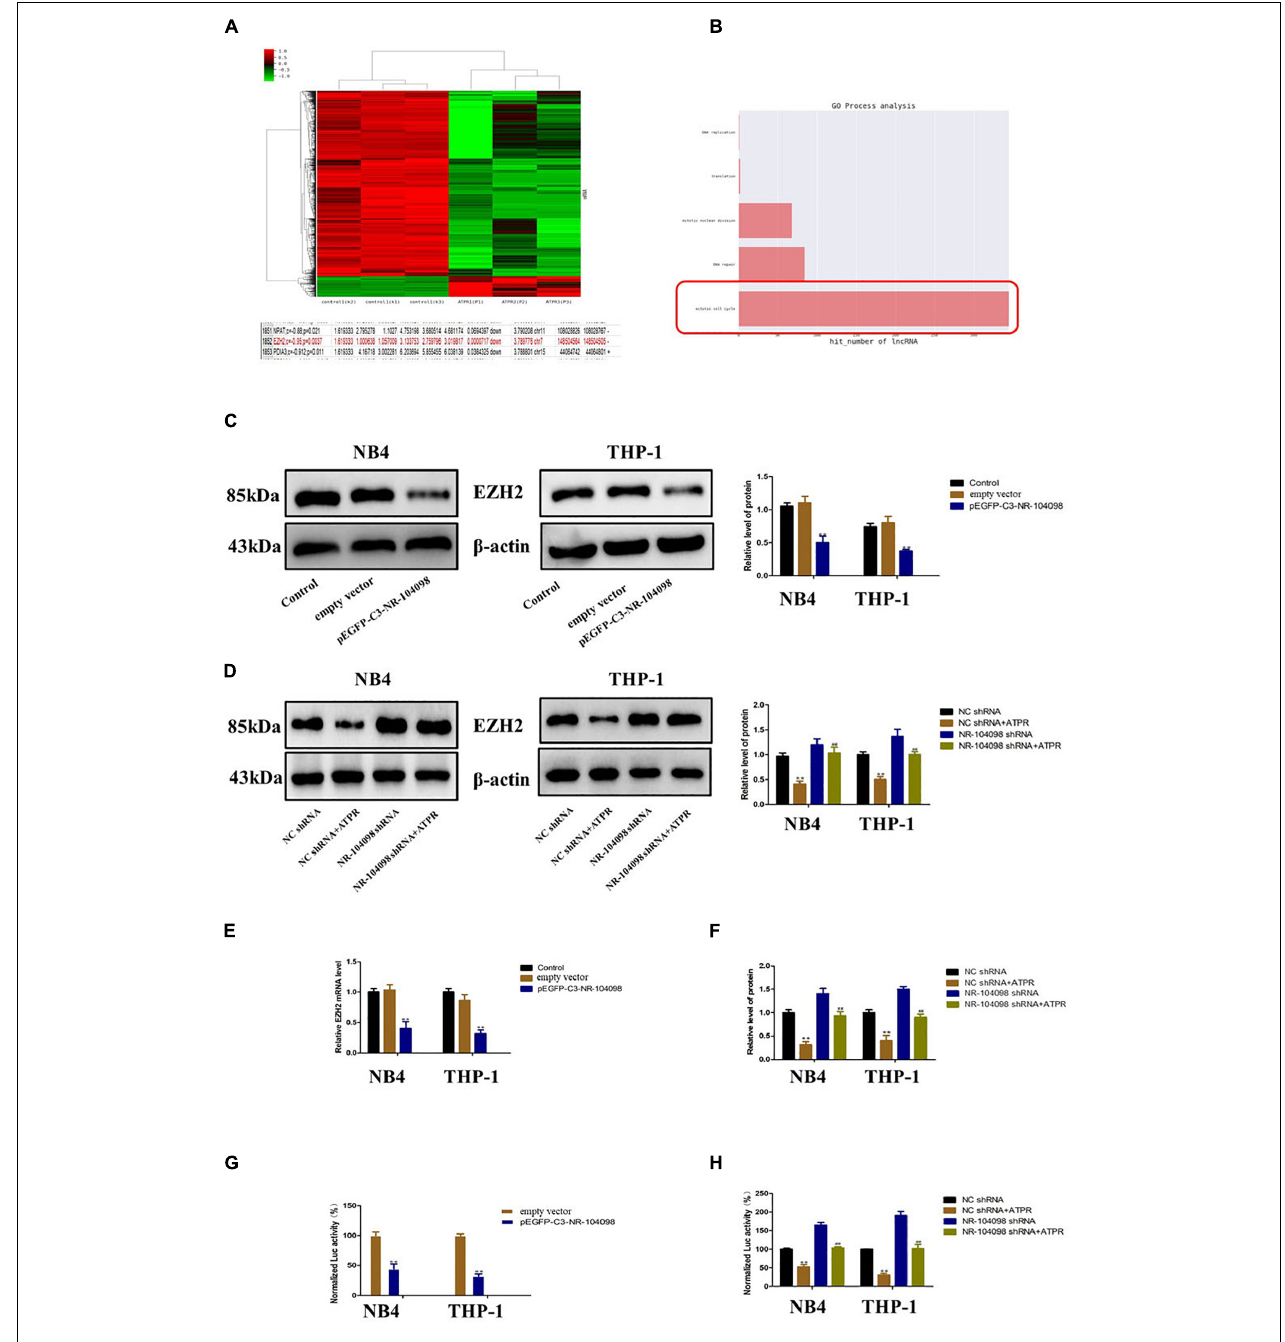
FIGURE 7 | Upregulation of lncRNA NR-104098 inhibited EZH2 transcription in AML cells. (A) Microarray analyses results showed that lncRNA NR-104098 may regulate the oncogene EZH2. (B) GO process analysis results of lncRNA NR-104098 regulates cell cycle. (C) pEGFP-C3-NR-104098 or the empty vector was stably transfected into AML cells, and EZH2 protein levels were detected by Western-blot assay. (D) lncRNA NR-104098 shRNA or the NC shRNA was stably transfected into AML cells, the ATPR or Solvent was treated for 72 h, and the Western-blot assay indicated that lncRNA NR-104098 shRNA evidently inhibited ATPR-induced downregulation of EZH2 protein expression. (E) Either AML cells stably transfected with pEGFP-C3-NR-104098 or the empty vector were collected, and EZH2 mRNA levels were assessed by RT-qPCR assay. (F) Either AML cells stably transfected with lncRNA NR-104098 shRNA or NC shRNA were treated with ATPR or Solvent for 72 h, RT-qPCR showed that lncRNA NR-104098 shRNA remarkably reversed the inhibition of EZH2 mRNA expression by ATPR. (G) Either EZH2 transcriptional activities of AML cells stably transfected with pEGFP-C3-NR-104098 or the empty vector were assessed by luciferase reporter assay. (H) The cells were then treated with ATPR or Solvent. 72 h later, EZH2 transcriptional activities were analyzed, and the activity of firefly luciferase was normalized by luciferase reporter assay. β -Actin served as a loading control. Data are presented as the mean ± SD of three independent experiments. ∗ p < 0.05, ∗∗ p < 0.01, compared with the NC group. # p < 0.05, ## p < 0.01, compared with the ATPR group.